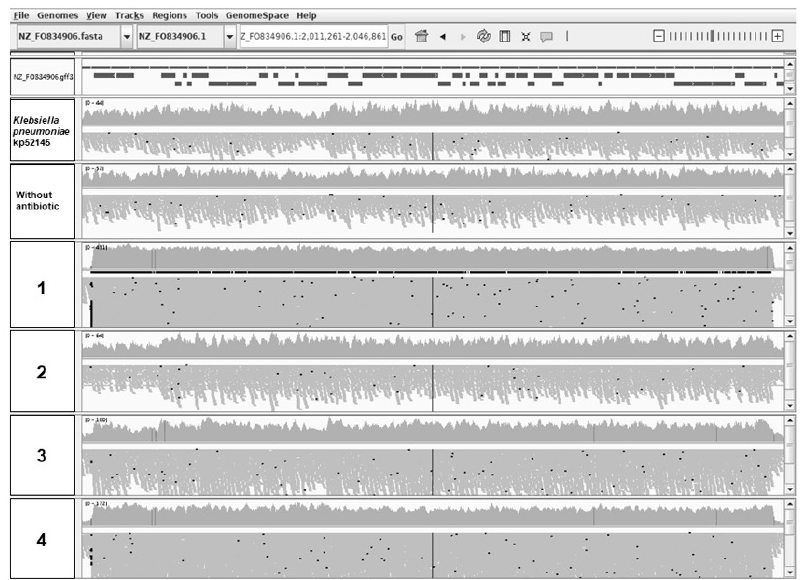
Figure 1. Image of the reads of the putatively amplified region obtained using Integrated Genome Viewer (IGV). An increased number of reads, mainly in populations 1, 3 and 4, which correspond with MICs of 128, 64 and 128 µg/mL, was observed.